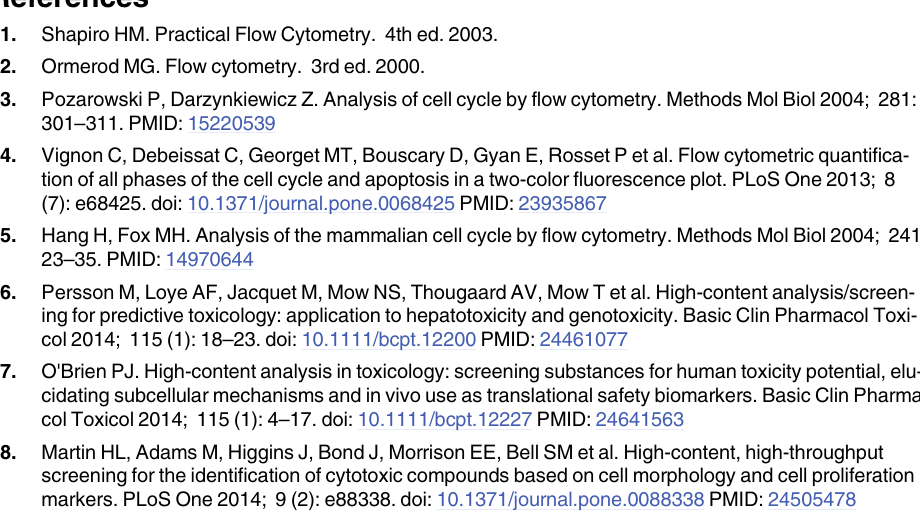
S1 Fig. Example scatter plot of nuclear area versus nuclear width. The nuclei of HT29 cells was stained with Hoechst 33342 and then segmented with Harmony software using Find Nuclei Method B. Nuclear area and width were calculated in Harmony Software using the building block [Calculate Morphology Properties], Method: